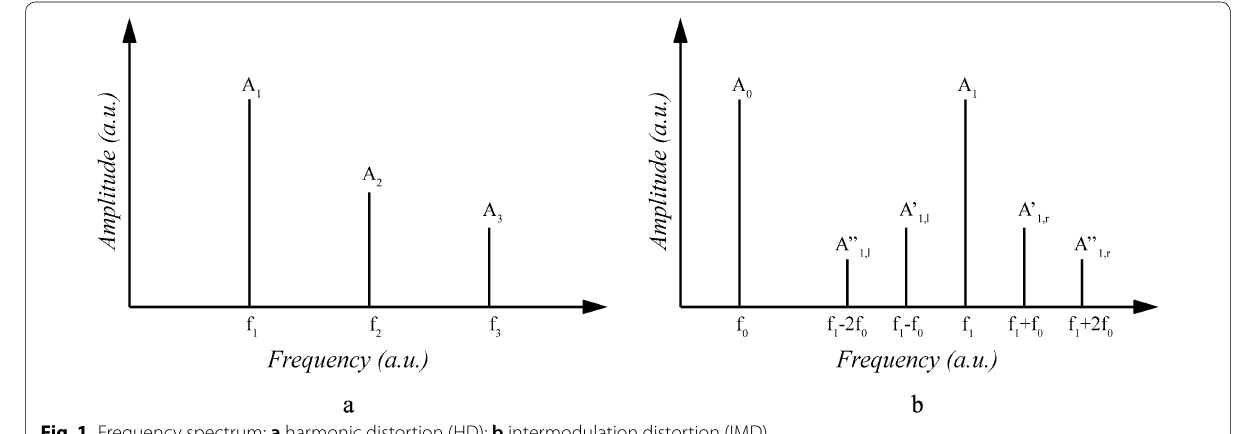
Fig. 1 Frequency spectrum: a harmonic distortion (HD); b intermodulation distortion